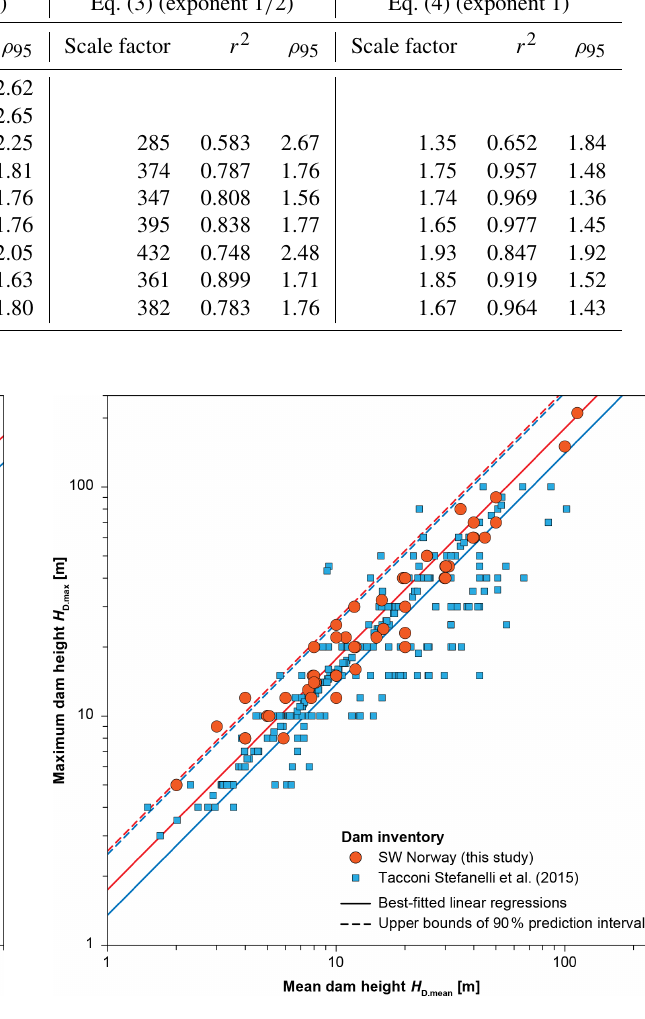
Figure 7. Linear relationship between maximum dam height H D . max and mean dam height H D . mean for RSF dams in southwest- ern Norway (data from Jakobsen, 2015), compared to the dataset from Tacconi Stefanelli et al. (2015). Linear regressions are as in Eq. (4) with scale factors as in Table 2, and the upper bounds of the 90% prediction intervals are shown with colours matching the point